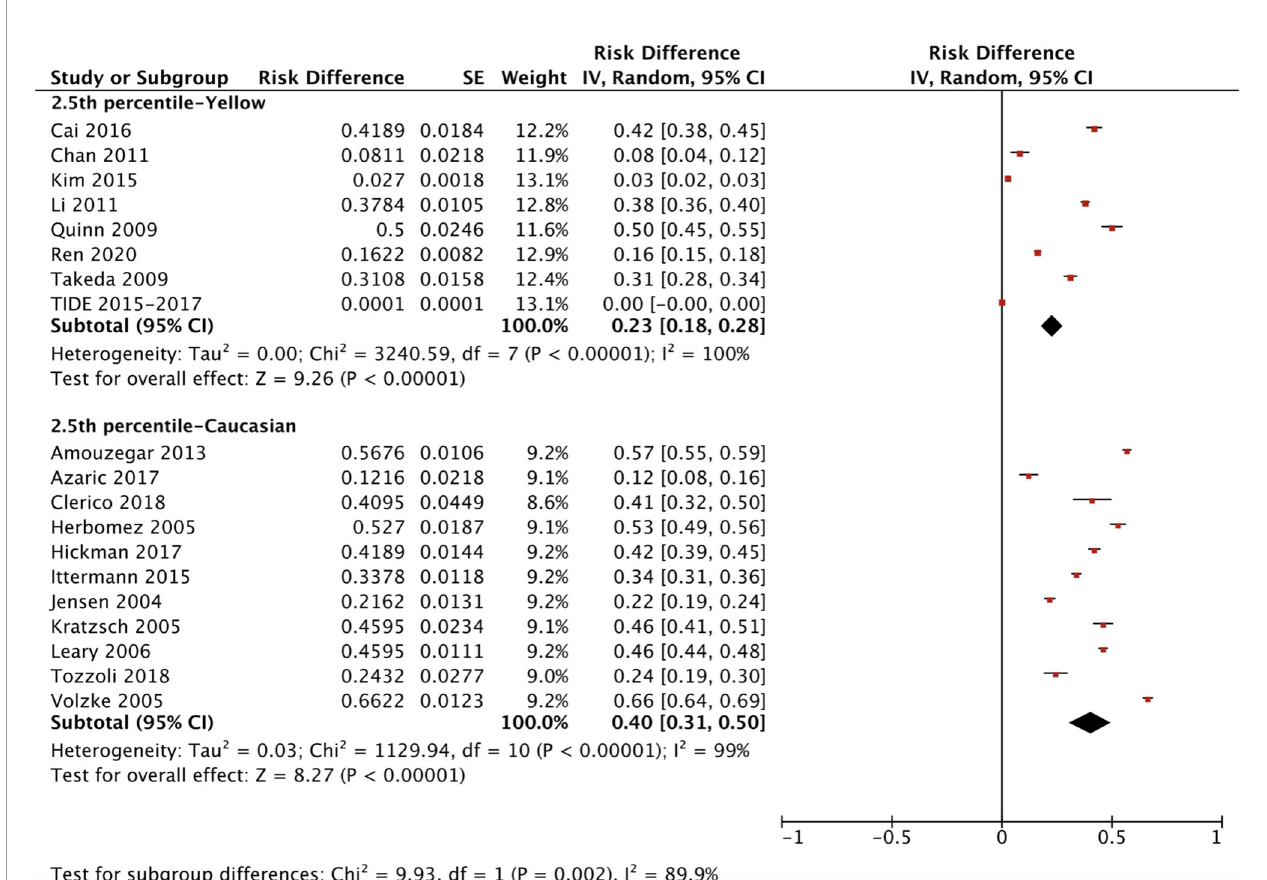
FIGURE 3 | Ethnicity standardized forest plots of the pooled relative descent rate (%) of TSH lower limits (2.5 th percentile) in NACB